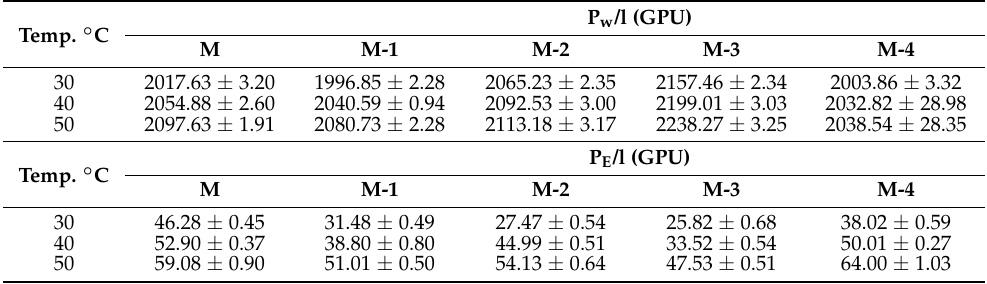
Table 2. The permeance of water and bioethanol of all the membranes at different temperatures. Temp. ◦ C